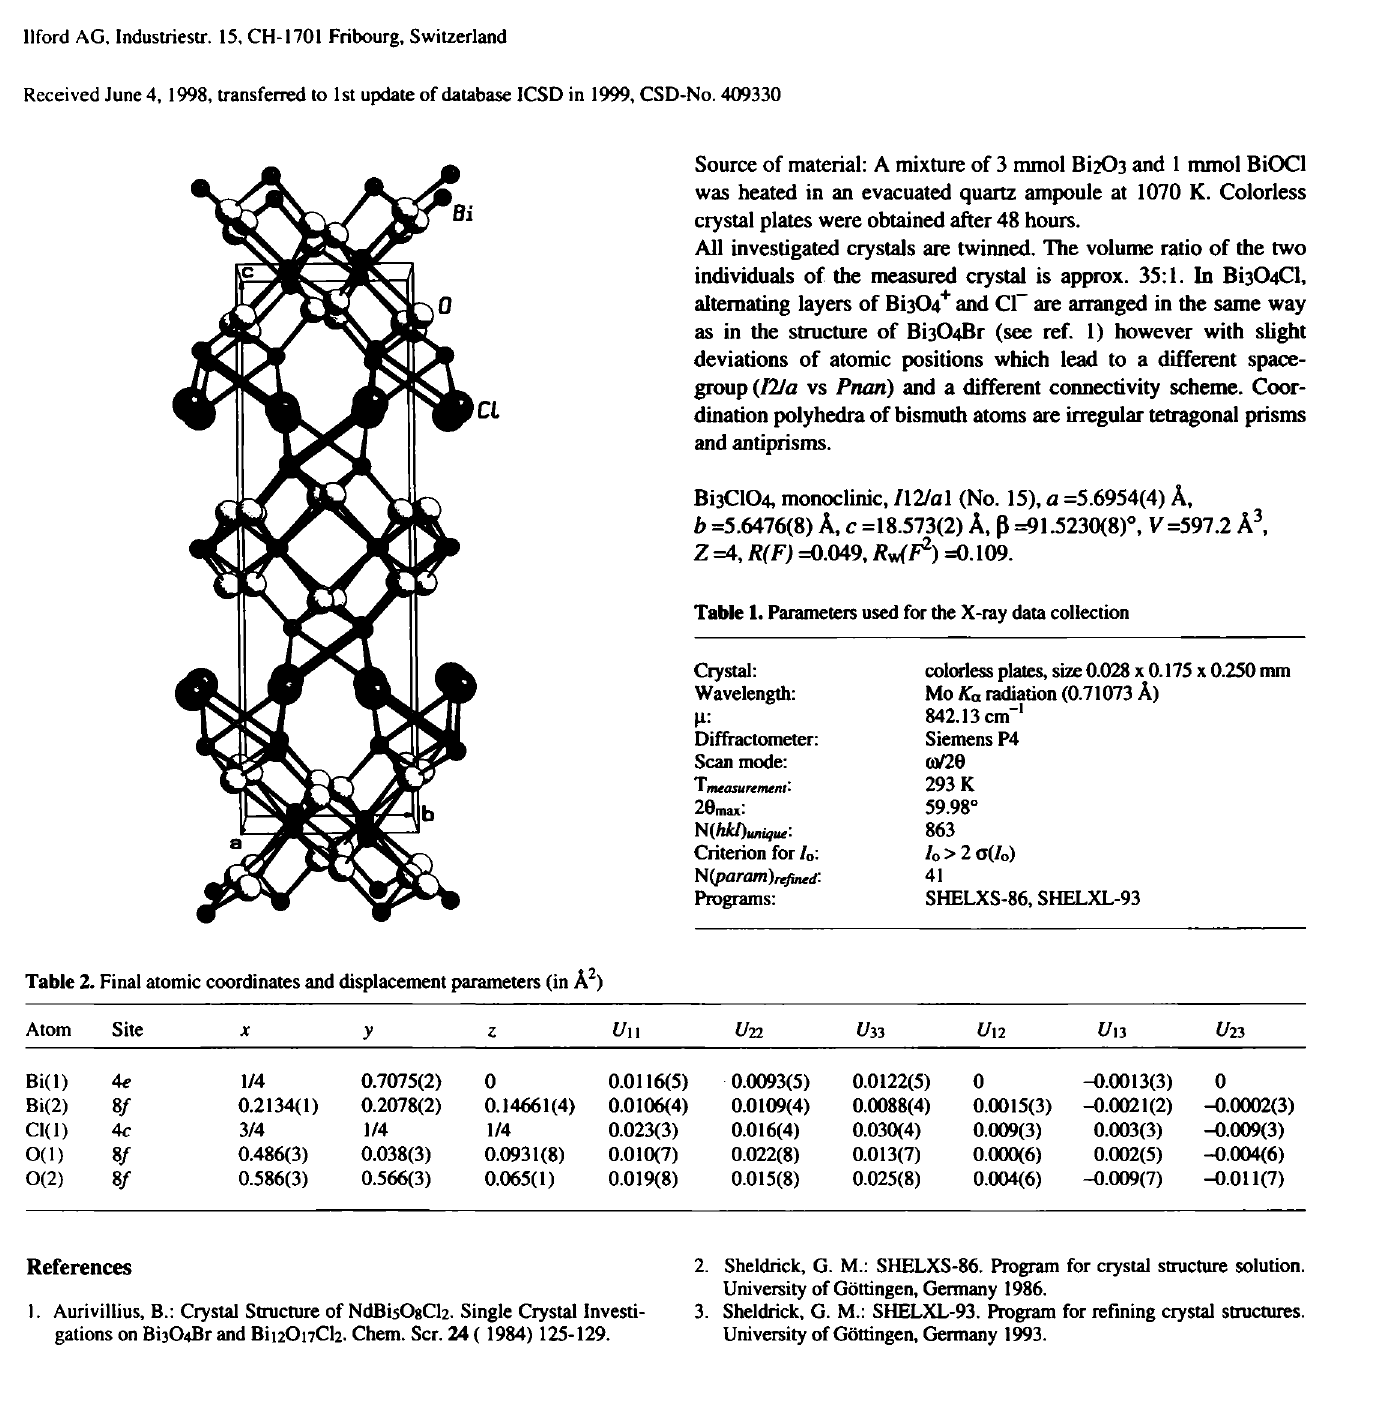
Table 2. Final atomic coordinates and displacement parameters (in Â^)